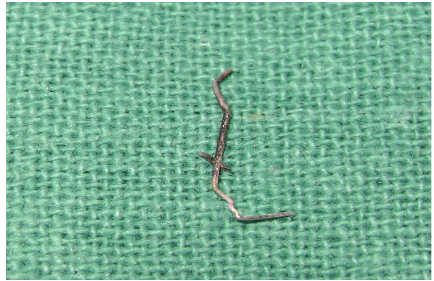
Figure 4: Removed stapler pin from the